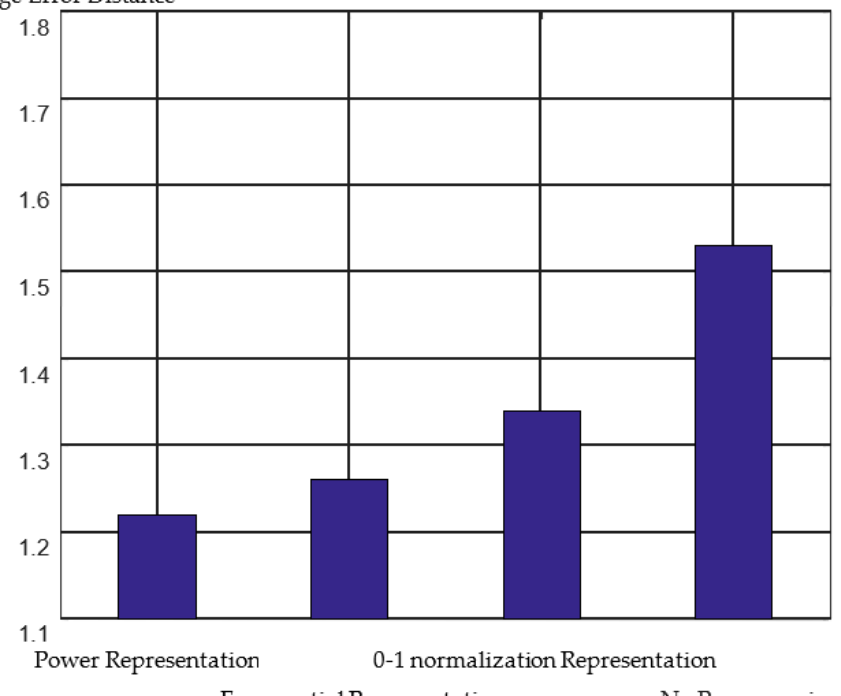
Figure 3. 3D positioning errors of different preprocessing methods.